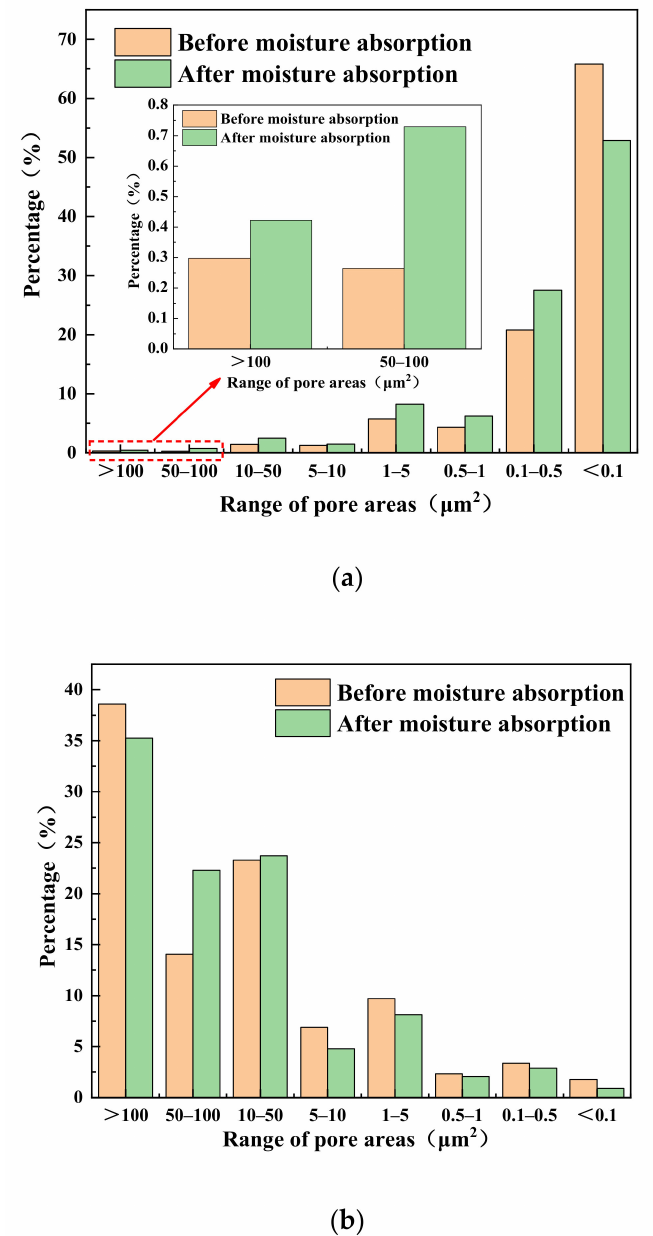
Figure 14. The distribution of pores according to the size of the area. ( a ) The vertical coordinate was the percentage of number of pores (the sum of the number of pores in the corresponding area range divided by total number of pores); ( b ) The vertical coordinate was the percentage of pore area (sum of pore areas in the corresponding area range divided by total pore